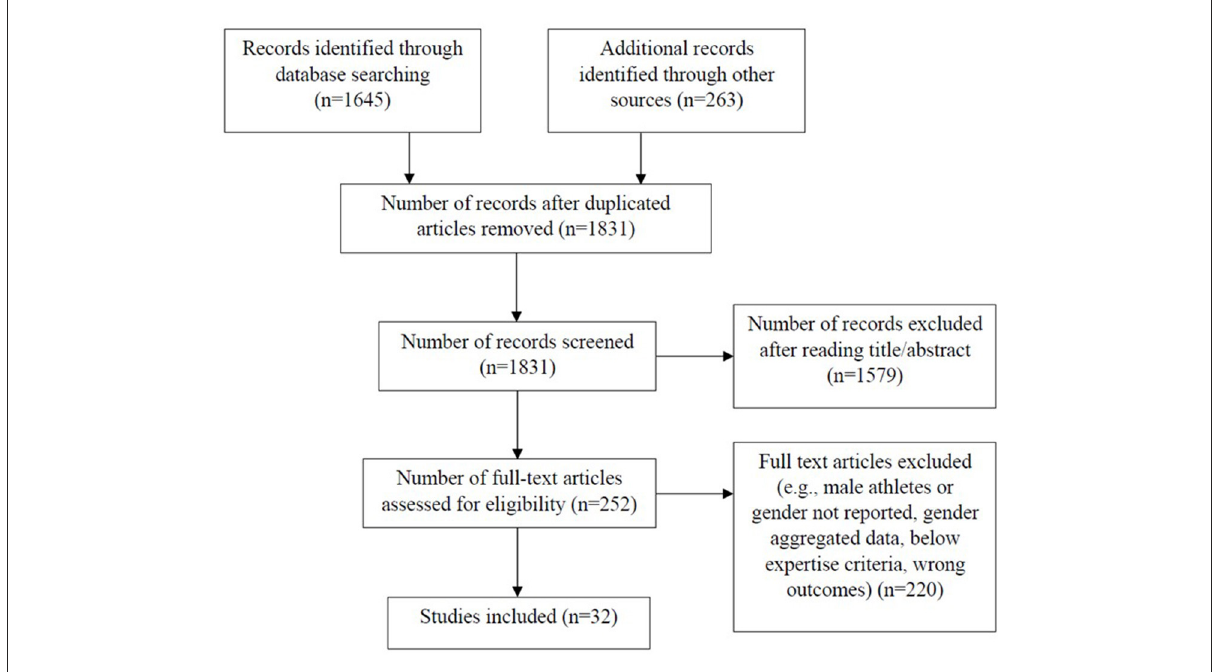
FIGURE1 PRISMA flow diagram for the scoping review